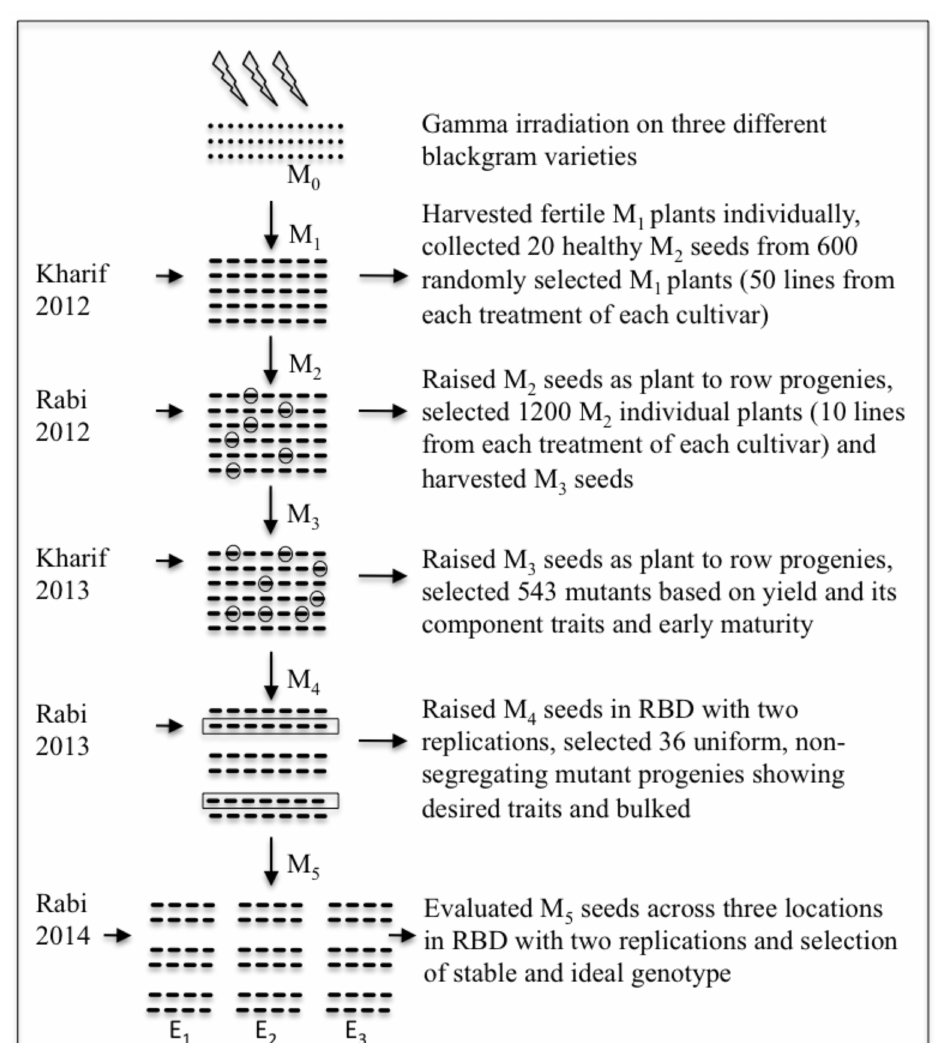
Figure 1. Schematic illustration for development of novel blackgram mutant and genotype × environment interaction for yield-related traits through mutation